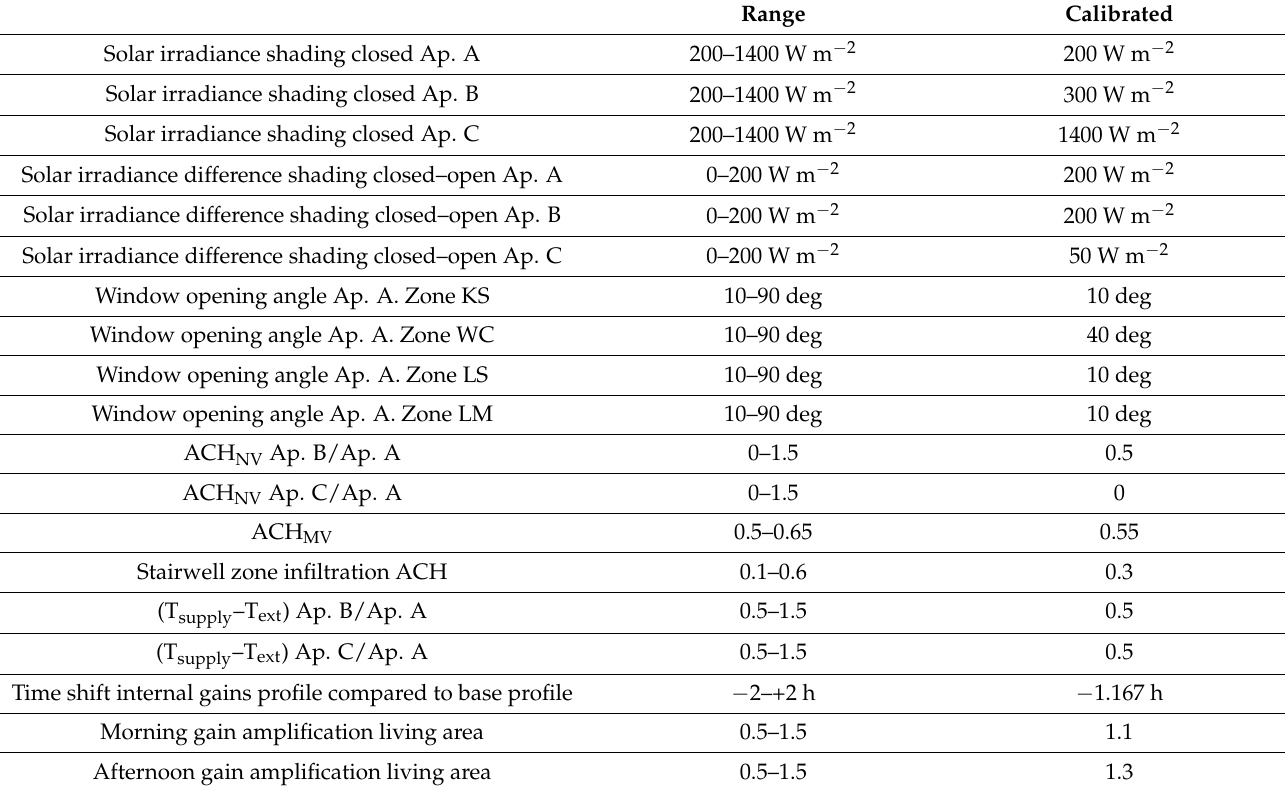
Table 8. UniTN-TRNSYS calibration of the building model: parameters range and calibrated